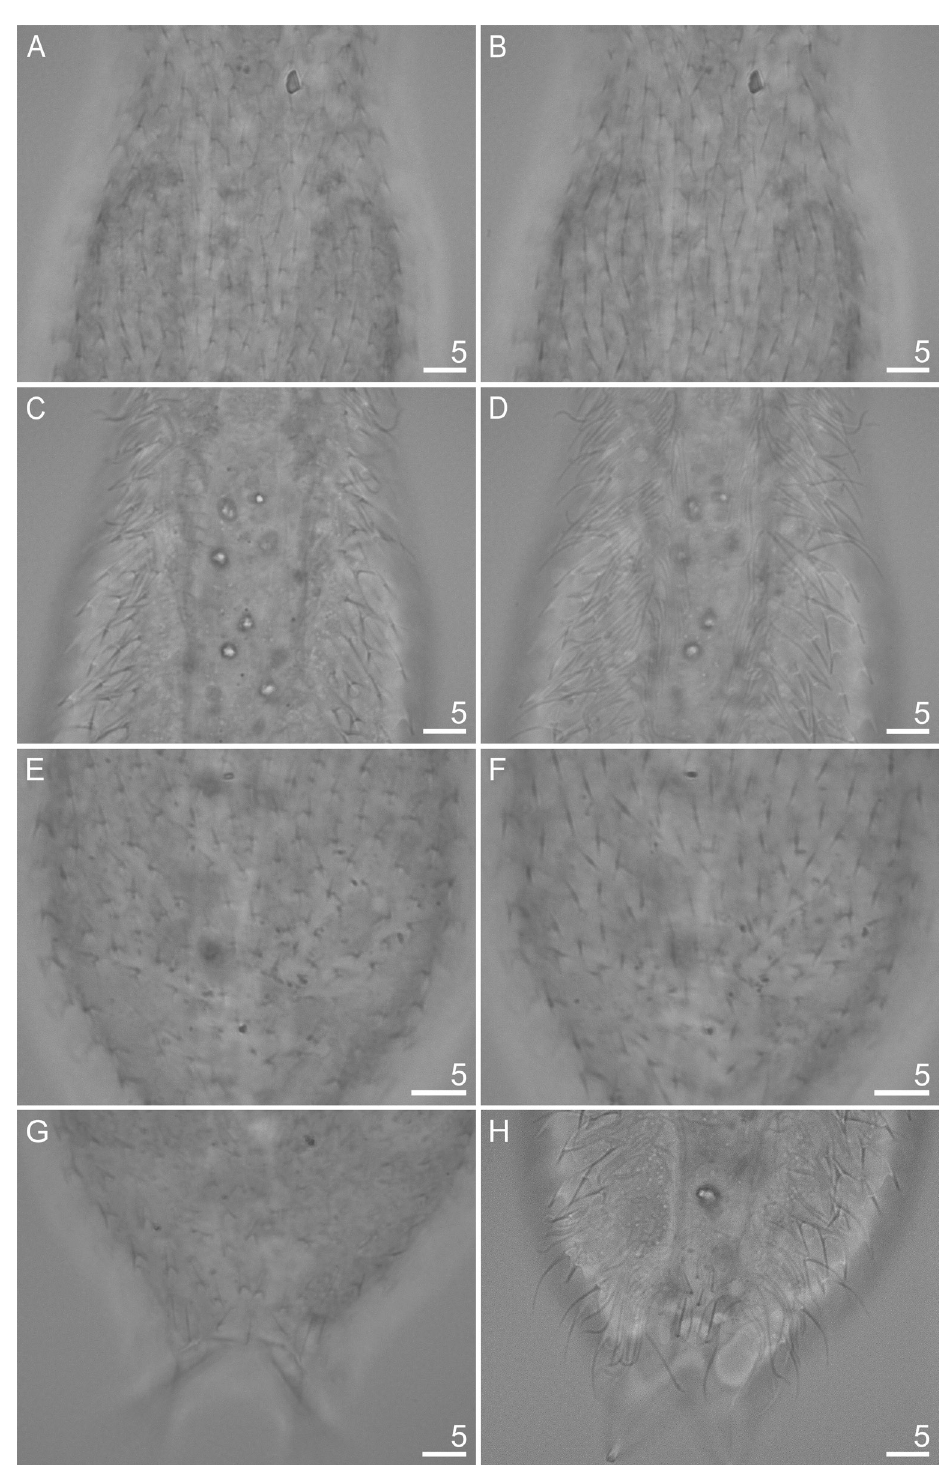
Fig. 8. Chaetonotus (Chaetonotus) antrumus Kolicka sp. nov., bright field microphotographs. A . Dorsal view of scales on trunk region. B . Dorsal view of spines on trunk region. C . Ventral view of scales on trunk region. D . Ventral view of spines on trunk region. E . Dorsal view of scales on posterior trunk region. F . Dorsal view of spines on posterior trunk region. G . Dorsal view of scales on furcal base and furcal appendages. H . Ventral view of posterior trunk region with visible interciliary field scales and posteriormost interciliary field